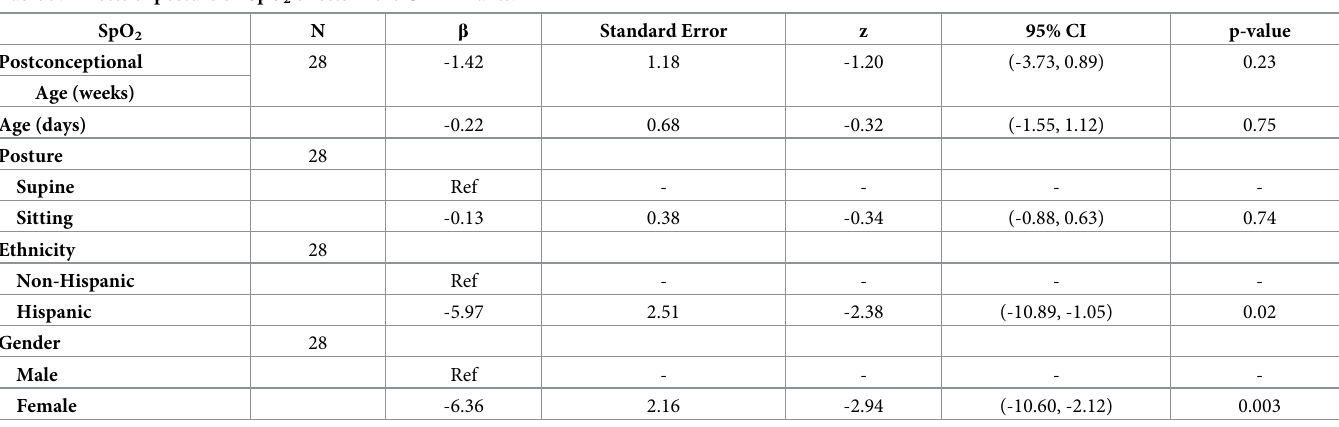
Table 7. Effects of posture on SpO 2 effects in the CHD